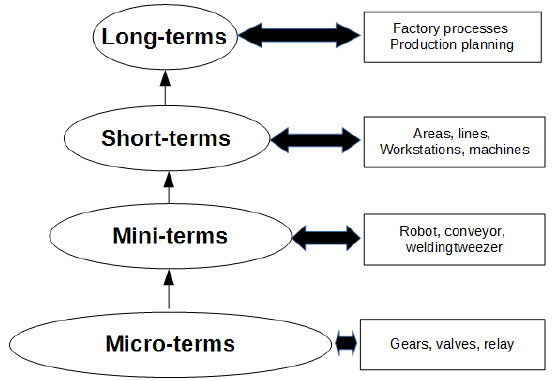
Figure 3. From micro-term to